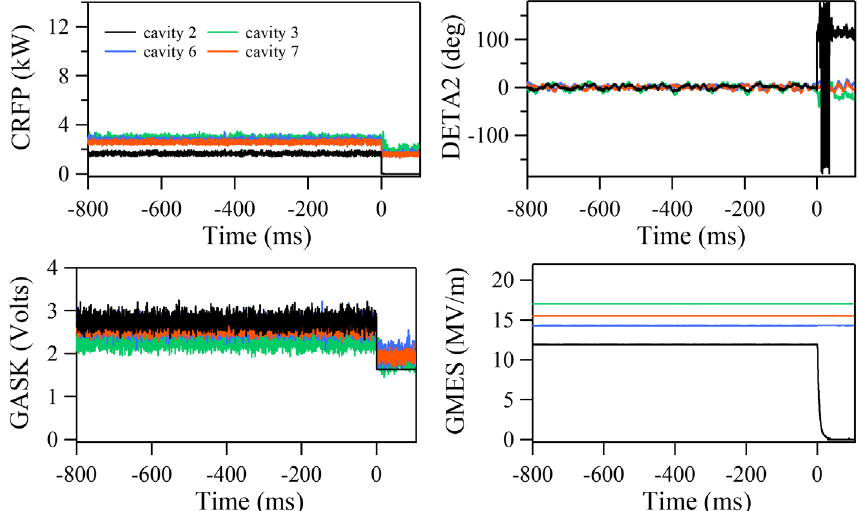
FIG. 16. Waveforms for a single-cavity turn-off. The plots display the forward power (top left), detune phase angle (top right), a digital signal proportional to the drive voltage (bottom left), and the measured gradient (bottom right). Only four of the eight cavities are plotted for clarity. Note that the vertical scale of the GASK signal has been modified.